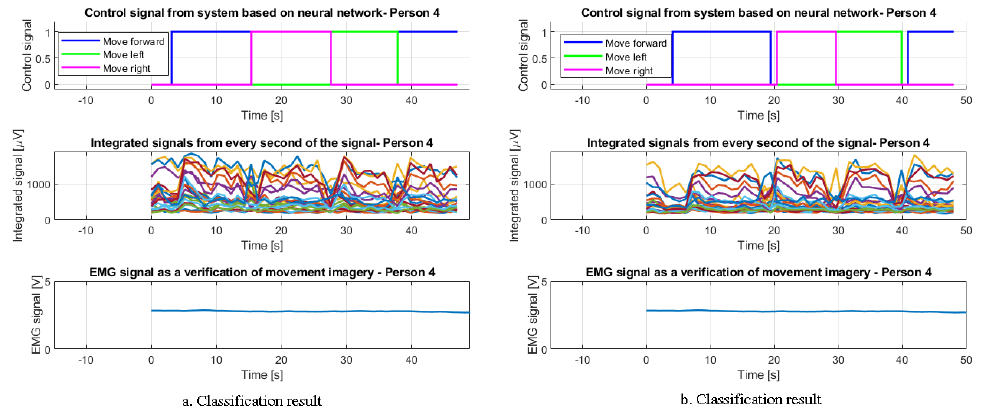
Figure 21. Observation of the signal classification and verification results—Person 4.